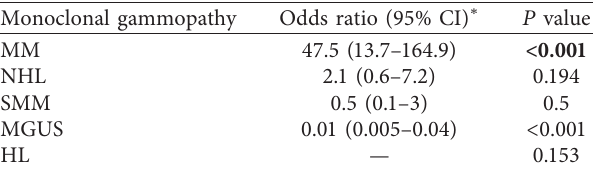
Table 6: Association between monoclonal gammopathies and direct kidney